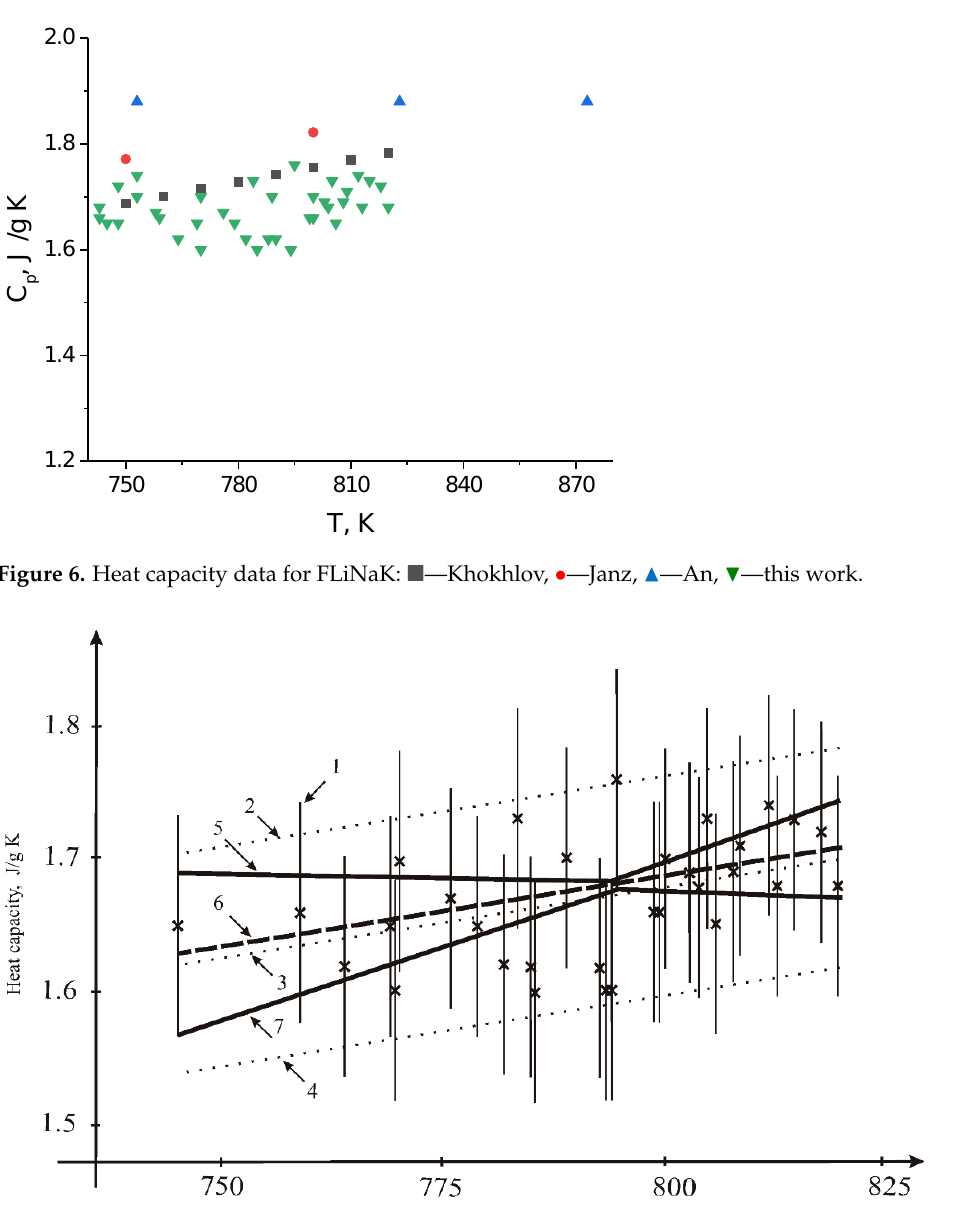
Figure 8. Fitting results for the thermal conductivity of the sample n = 22: 1 — measurements (×) and their uncertainty intervals; 2, 4 — the range of admissible values according to the LSQM (± 2σ); 3— the LSQM dependence; 5, 7 — interval estimates of the upper and lower limits of admissible values of the dependencies; 6 — interval estimation of linear dependence.